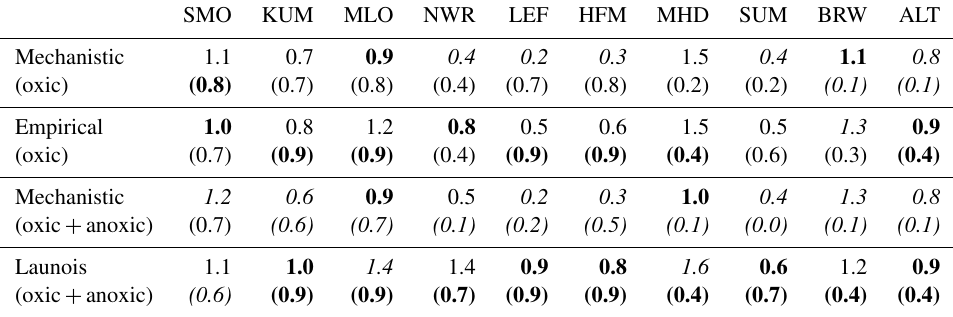
Table B2. Normalized standard deviations (NSDs) of the simulated concentrations by the observed concentrations. Within brackets are the Pearson correlation coefficients ( r ) between simulated and observed COS concentrations for the mechanistic and empirical approaches, calculated between 2011 and 2015 at selected NOAA stations. For each station, NSD and r values closest to one are in bold, and the farthest ones are in italic. The time series have been detrended beforehand and filtered to remove the synoptic variability (see Sect.